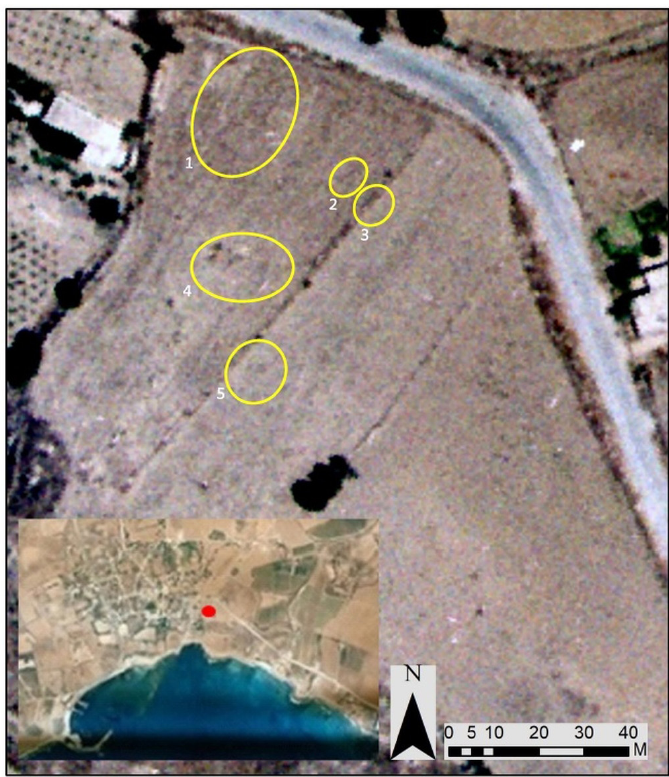
Figure 6: 1968 aerial photograph: red dot on bottom left view indicates a specific area within the Eastern necropolis, with notable archaeolo- gical proxy concentration. A closer view of this area is shown in the background image. Yellow circles denote archaeological proxies further explained in Table 2